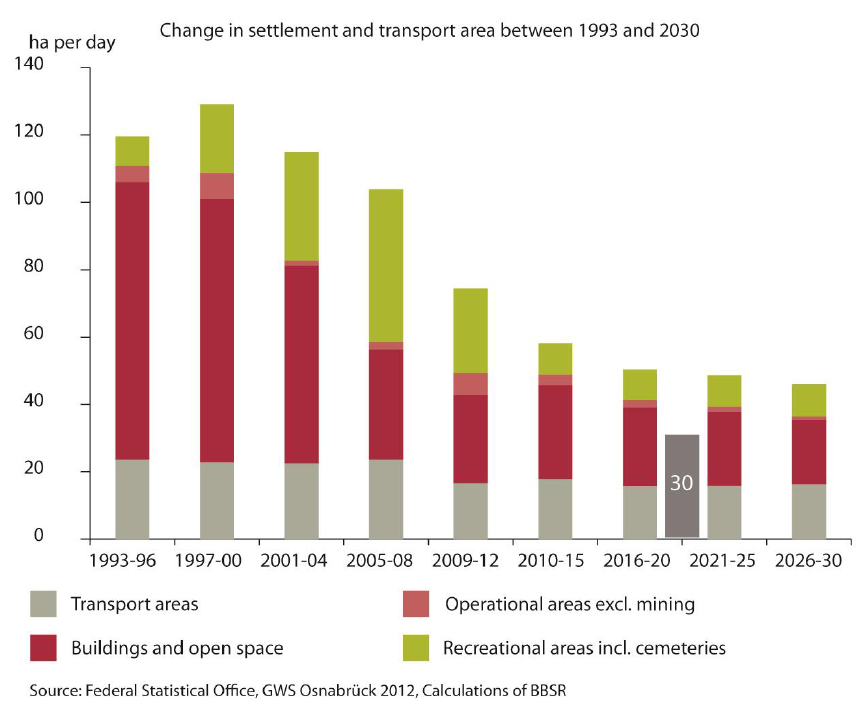
Figure 2. Daily land consumption for built-up and transport area between 1992 and 2030 for the reference scenario.